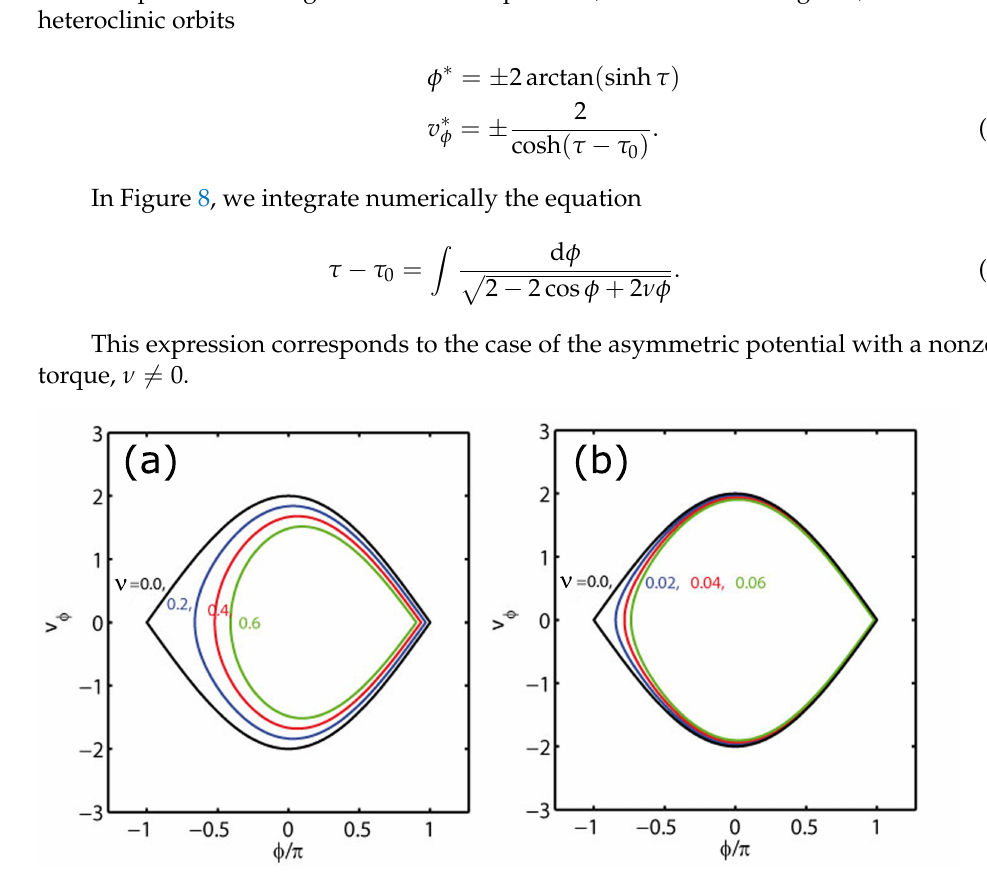
Figure 8. Computation of the heteroclinic (for the torque ν = 0.0) and homoclinic (for the torques ν = 0.2, 0.4, 0.6) orbits in ( a ), and ν = 0.02, 0.04, 0.06) in ( b